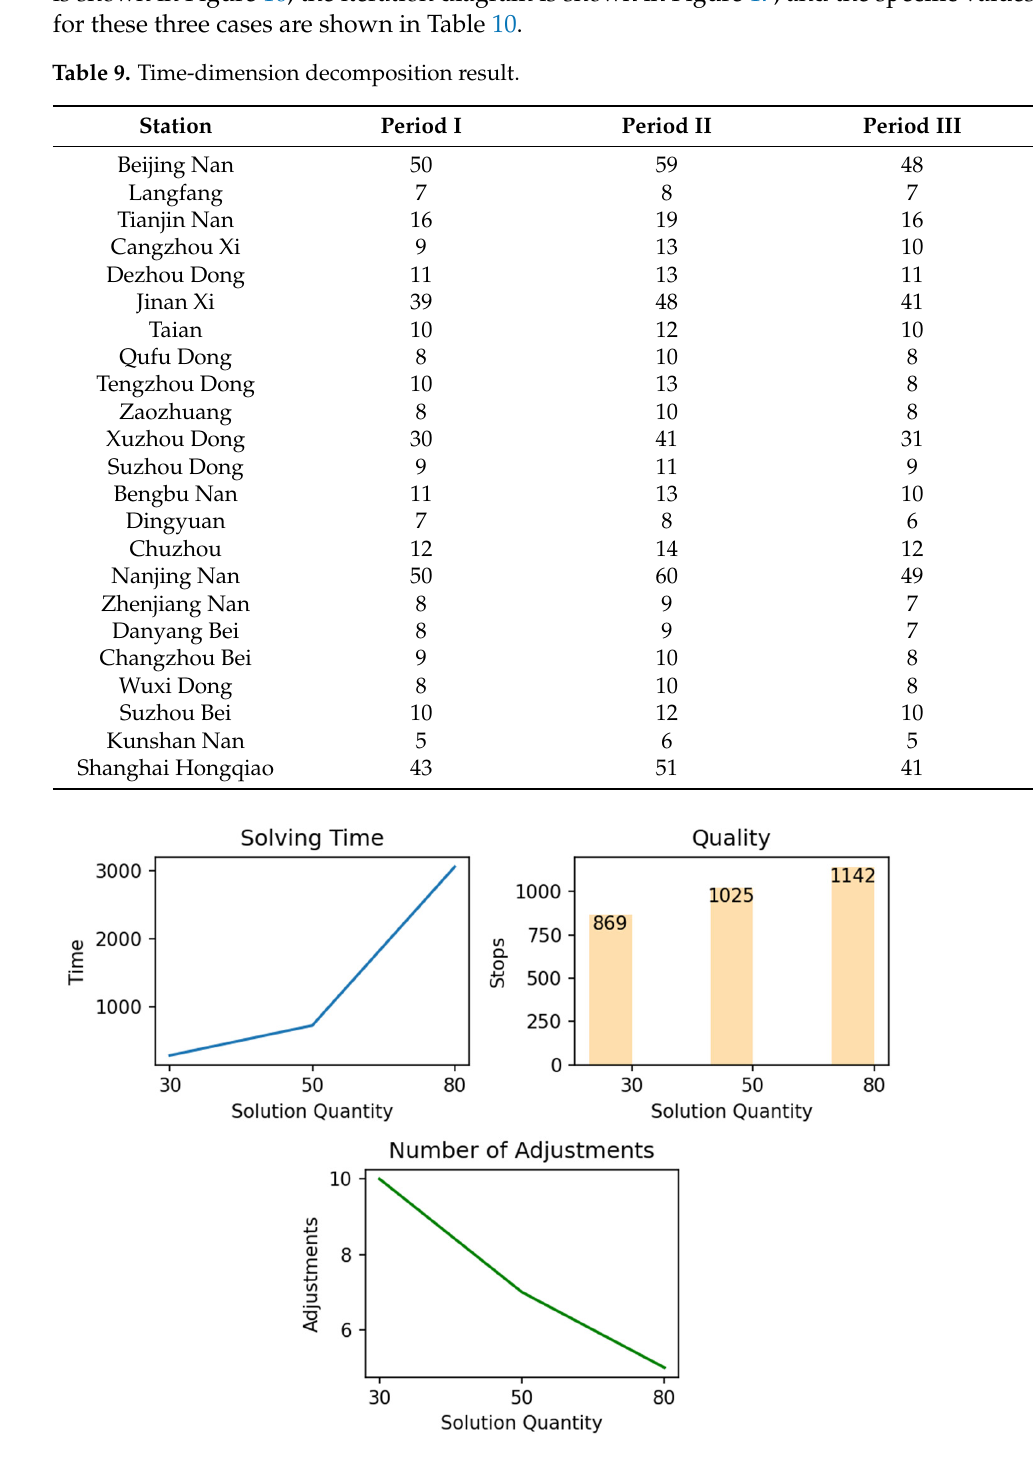
Table 9. Time-dimension decomposition result.